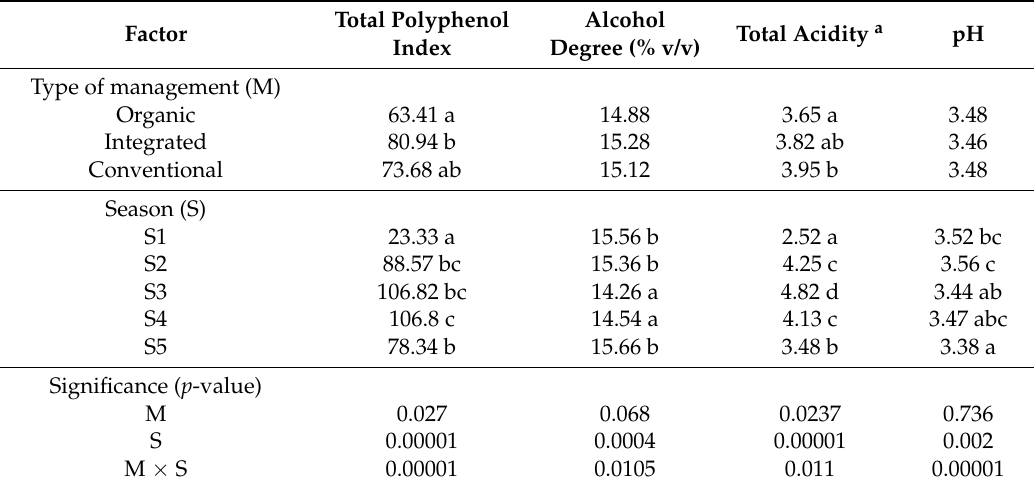
Table 4. Effect of organic, integrated and conventional management on wine oenological parameters obtained from Cabernet Sauvignon grapevines evaluated during 5 consecutive